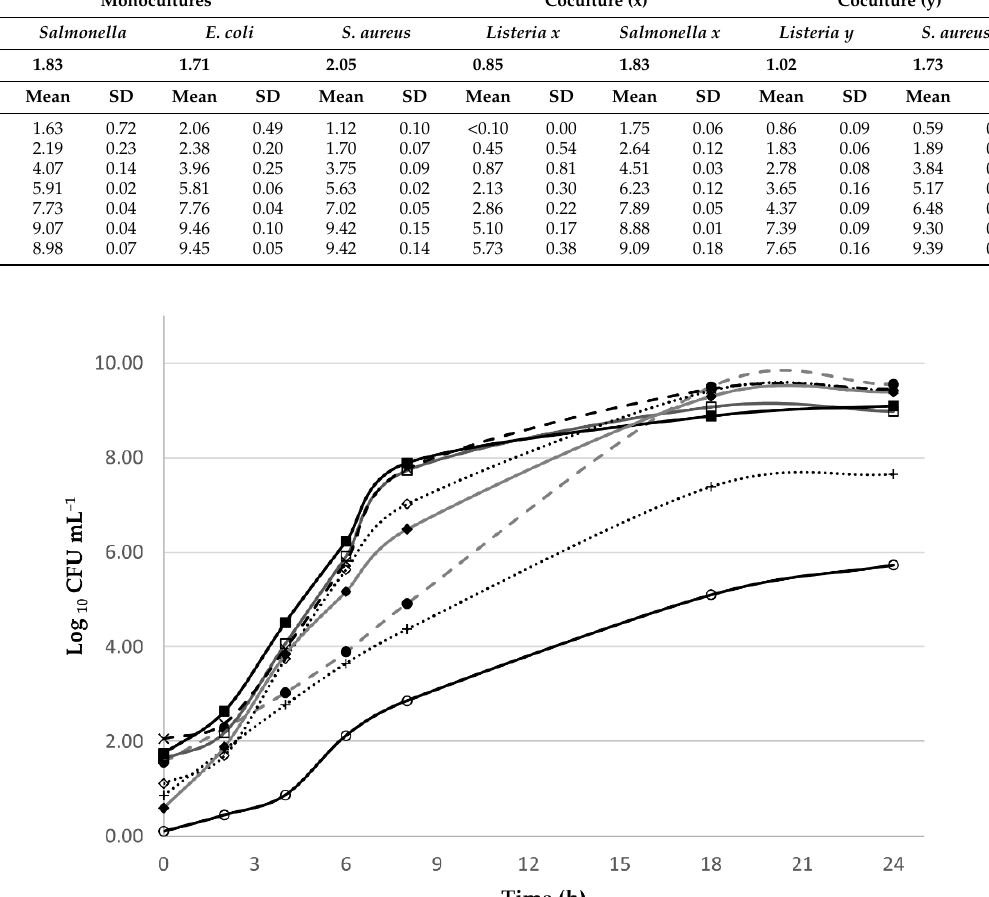
Figure 2. Growth kinetics of monocultures: L. monocytogenes (dashed grey • ), S. enterica (grey (cid:3) ), E. coli (dashed black × ), S. aureus (dotted black ♦ ); cocultures: L. monocytogenes (x) (black ), S. enterica (x) (black (cid:4) ); L. monocytogenes (y) (dotted black + ), and S. aureus (y) (grey ). Table 1. Growth kinetics of Listeria monocytogenes , Salmonella v. Typhi, E. coli O157:H7, and S. aureus in monoculture, and Listeria + Salmonella in coculture (x) and Listeria + S. aureus in coculture (y). Results are expressed as the mean ( n = 3) ± SD of Log CFUmL −1 .